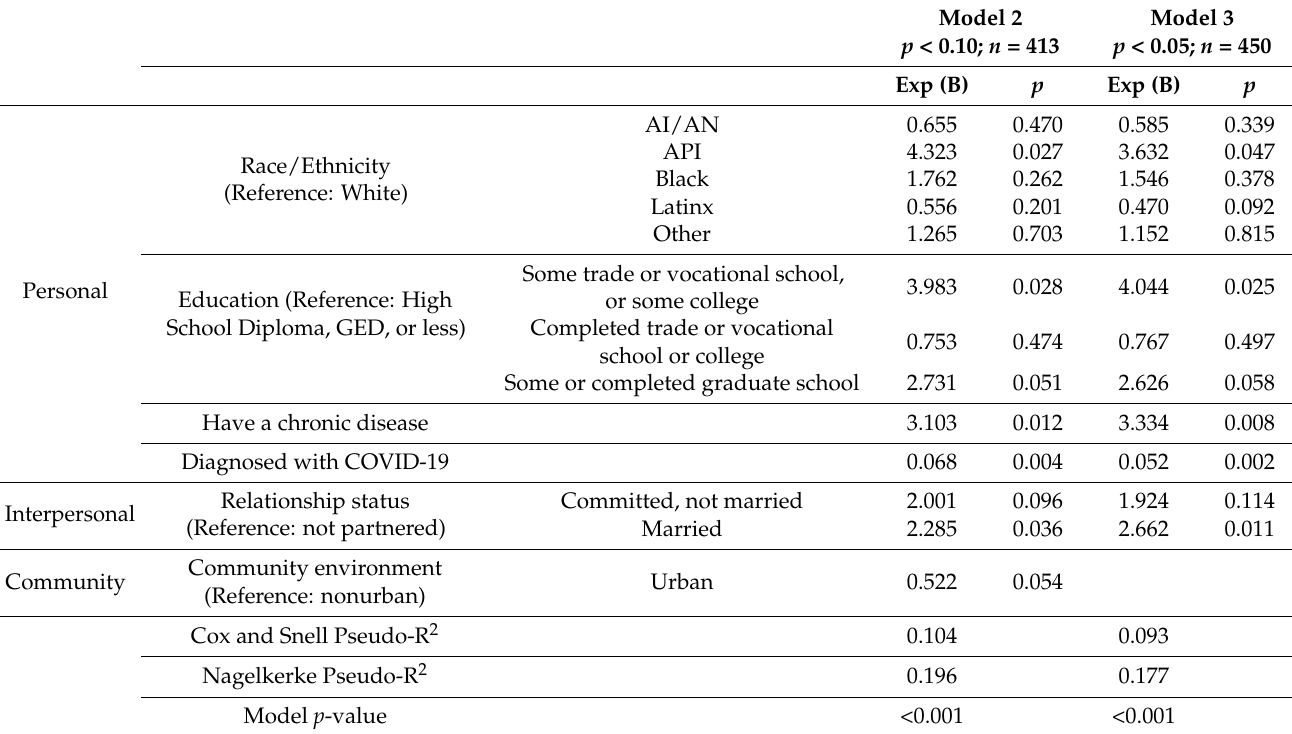
Table 4. Binary logistic regressions for outcome 2, physically distancing six feet.